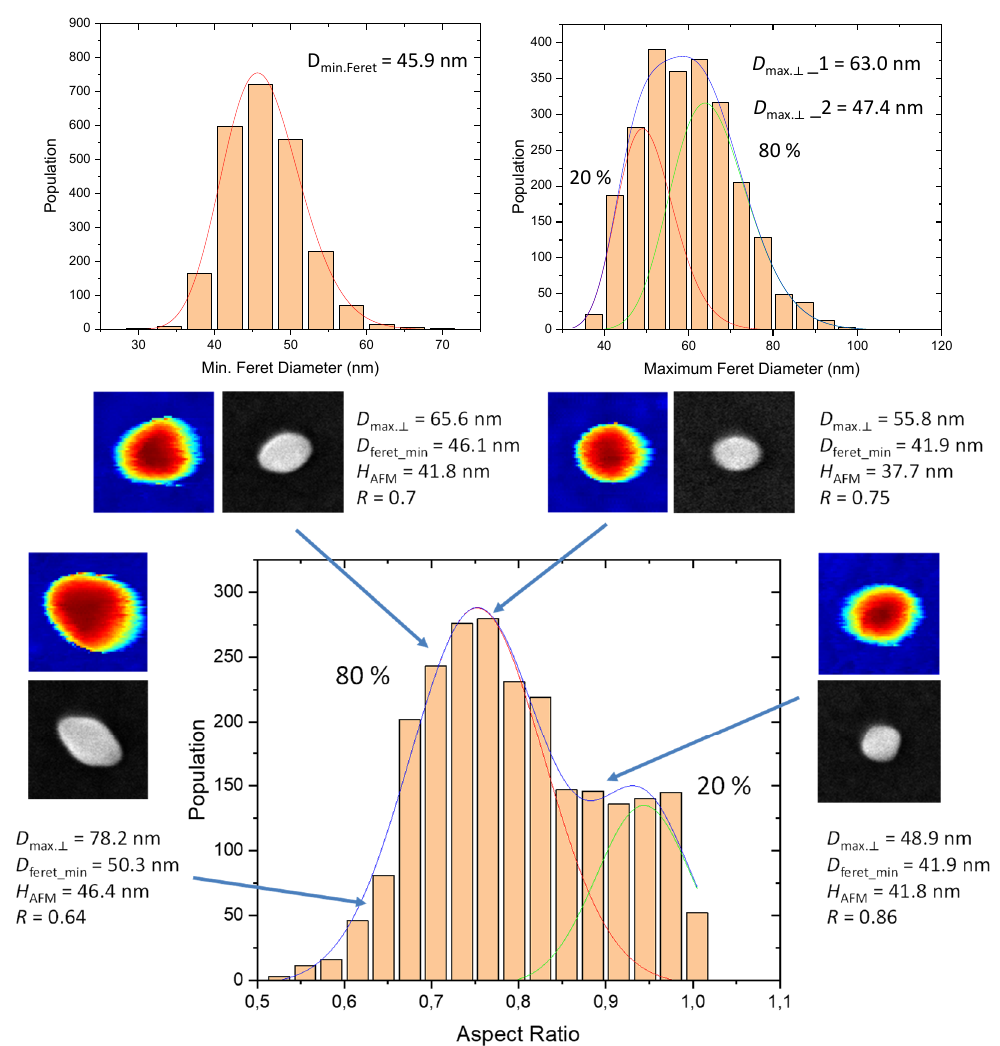
Figure 7. Schematic view of the two possible orientations, noted 1 ( a ) and 2 ( b ), of nanobipyramides on the substrate after deposition for microscopy measurements.